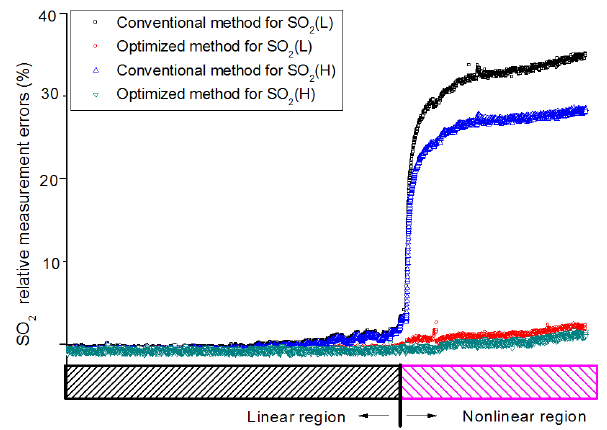
Figure 9. Comparison of measurement bias (a) and measurement errors (b) for all concentrations in the laboratory experiment. The measurement bias obviously increases with increasing concentra- tions. Measurement errors for high concentrations are smaller than those for low concentrations. Table 5. SO 2 measurement results and corresponding measurement errors. Gas mixtures (H 2 O, CO 2 , CO, NO x , and SO 2 ) with 15 dif- ferent concentrations of SO 2 are measured in sequence; 5 and 10 concentrations of these gases lie within the measurement range of the SO 2 (L) and SO 2 (H) channel, respectively.